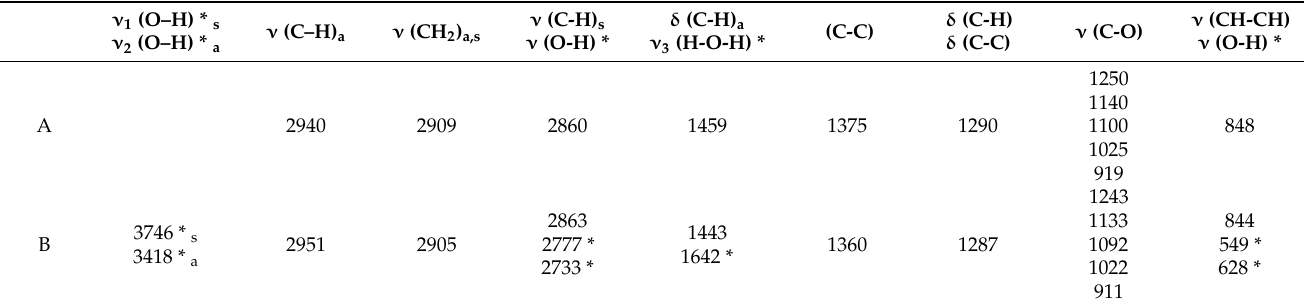
Table 2. FTIR analysis [cm –1 ] of 12-crown-4 (A) [28,30,32] and [Cu(12-crown-4) 5 (H 2 O) 6 ]I 6 · 2I 2